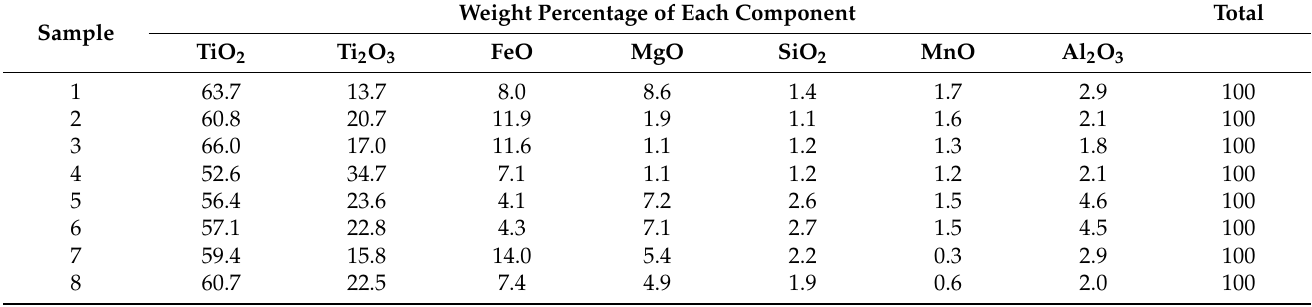
Table 1. Weight percentage of each component in the slag samples measured using ICP-OES. The trivalent titanium content was analyzed by a titration-based method. SiO 2 was measured using Skalar Segmented Flow Analyzer (SFA